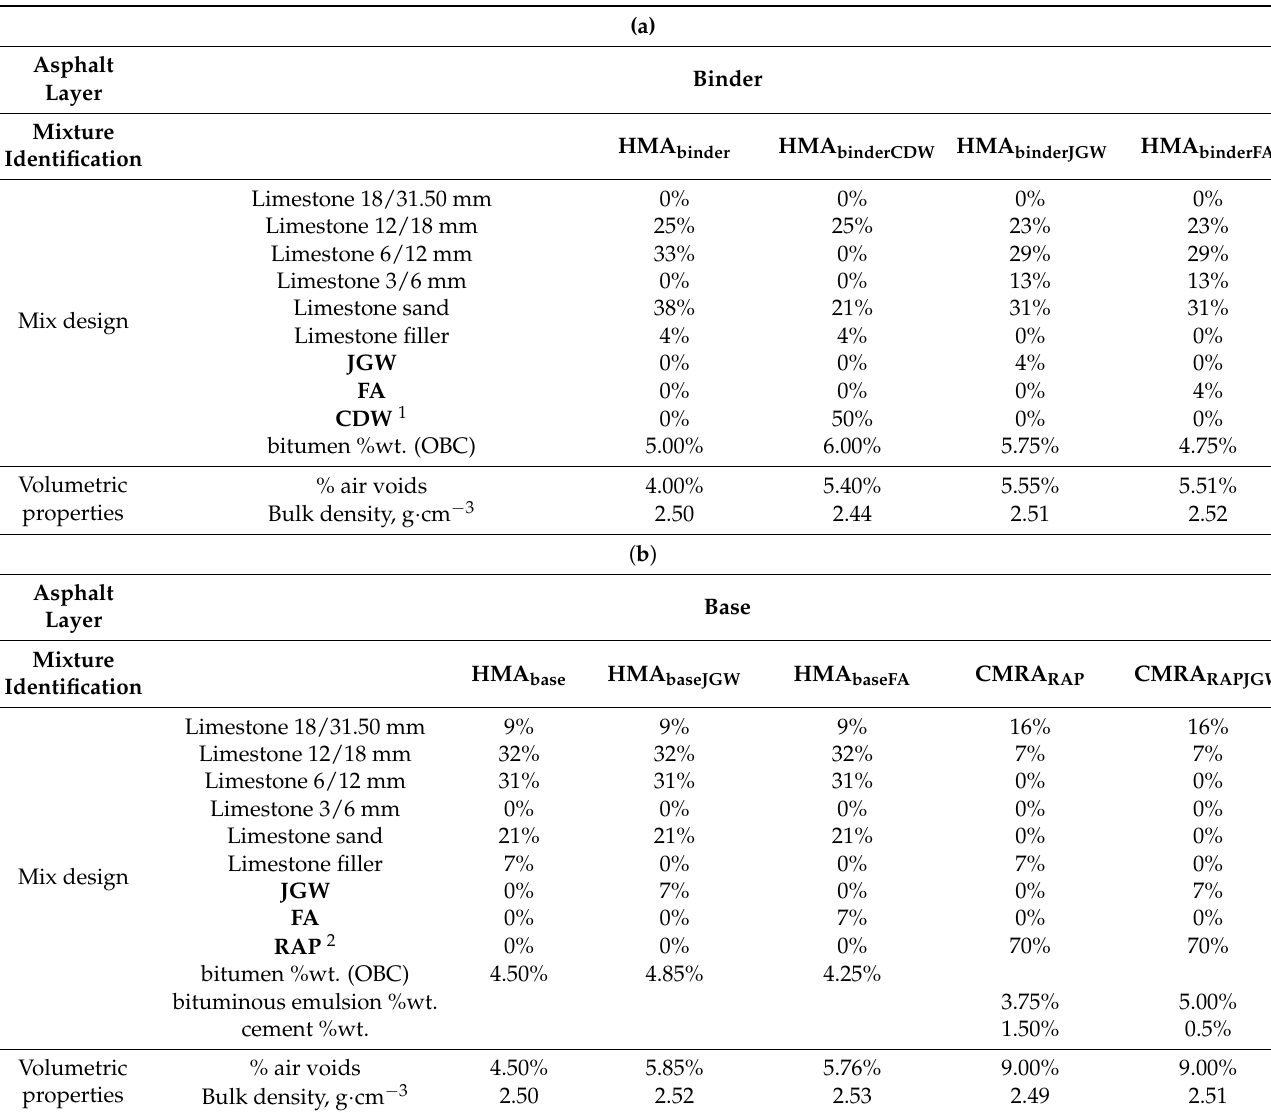
Table 2. Mix designs of the ( a ) binders and ( b ) base layers in the studied asphalt mixtures.